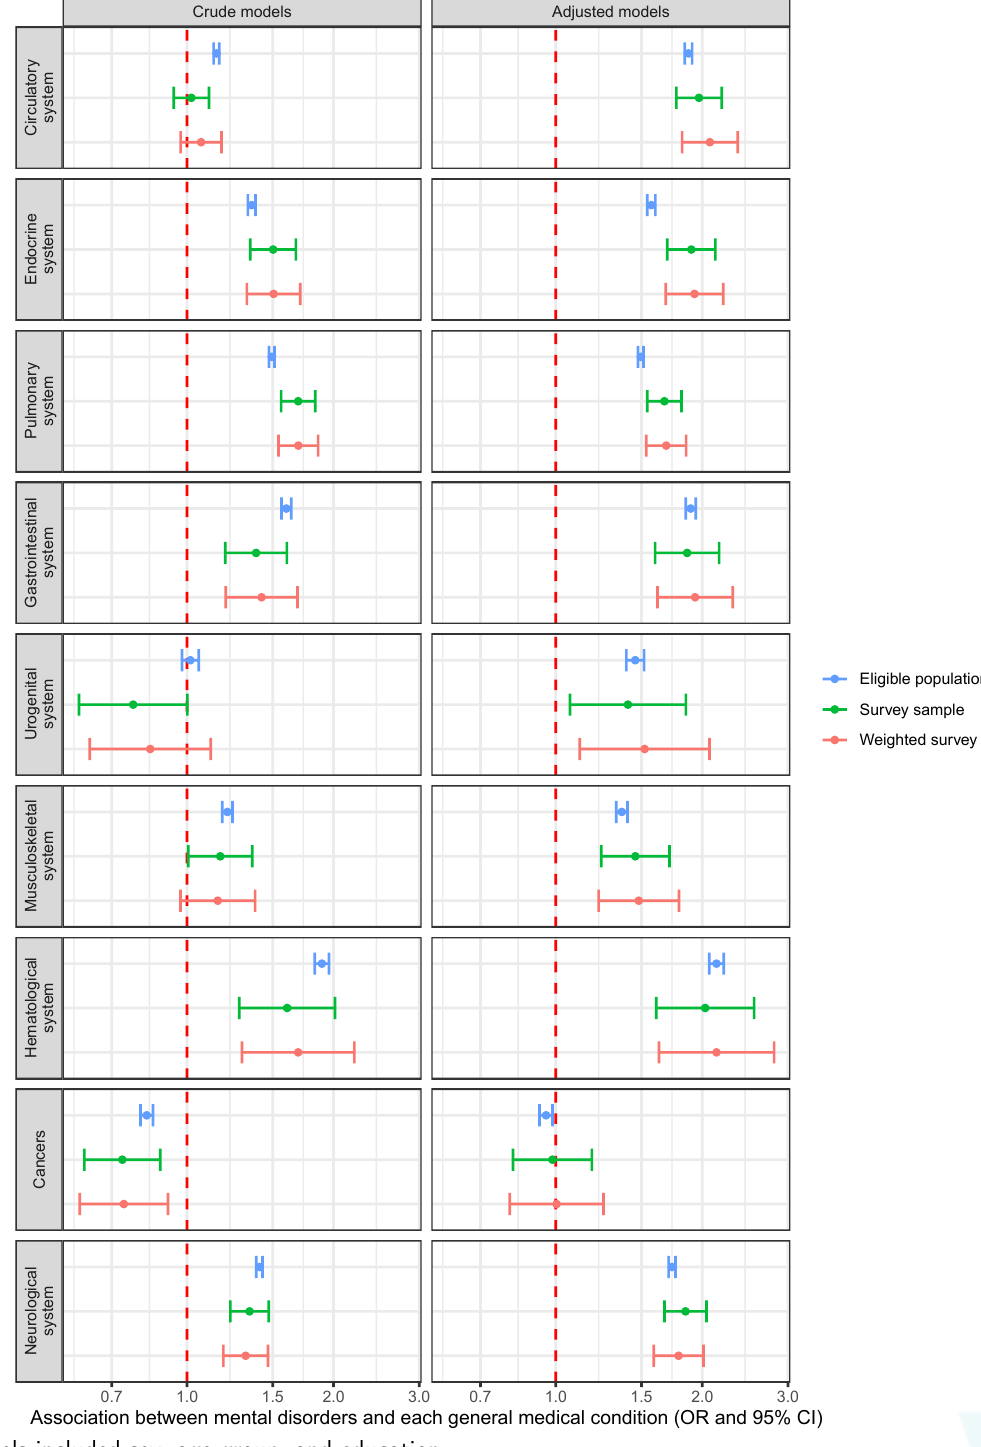
Figure 3: Odds ratios (and 95% confidence intervals) for associations between any mental disorder and nine general medical conditions, among all those eligible for the 2017 Central Denmark Region How are you? survey and the survey participants (before and after weights were applied) Crude models Adjusted